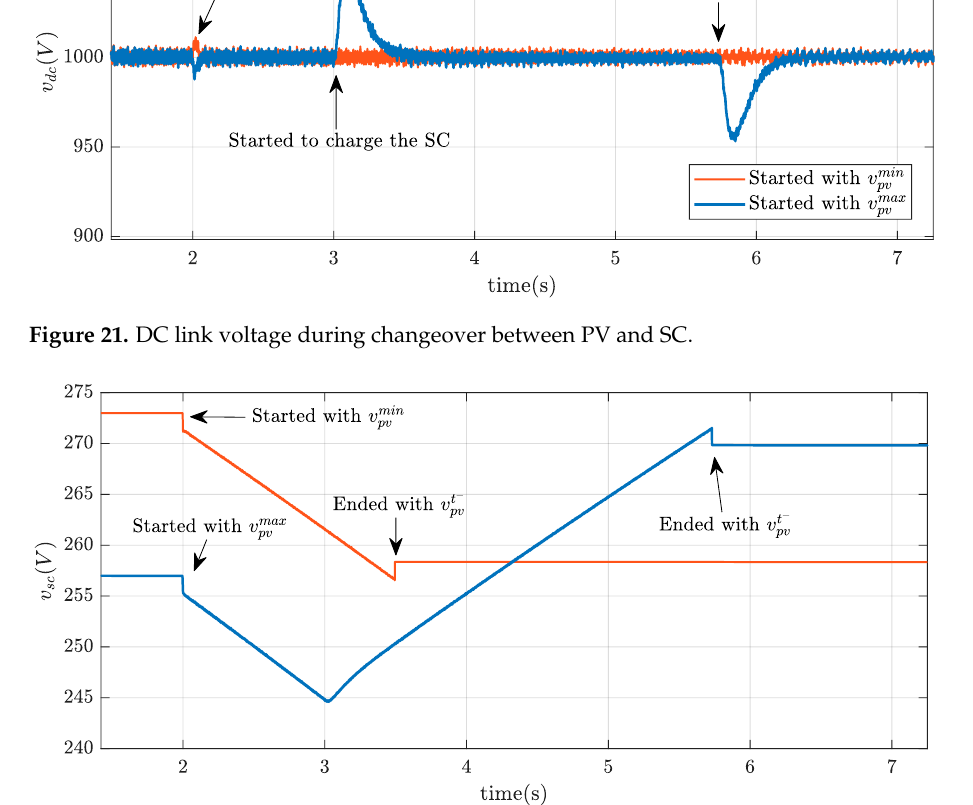
refers to the PV refers to the PV − − 𝑚𝑚𝑝𝑝𝑡𝑡 𝑚𝑚𝑝𝑝𝑡𝑡 𝑣𝑣 𝑣𝑣